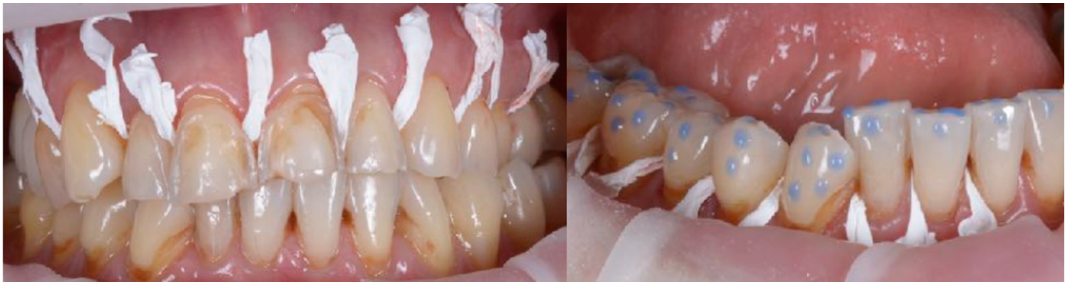
Figure 6. Selective etching of surfaces and application of adhesive system for better mock-up stability.